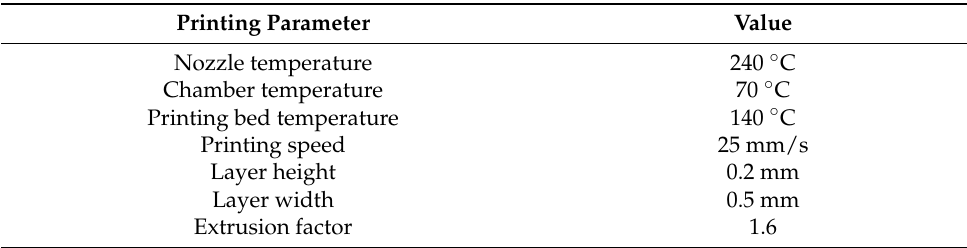
Table 1. Final printing